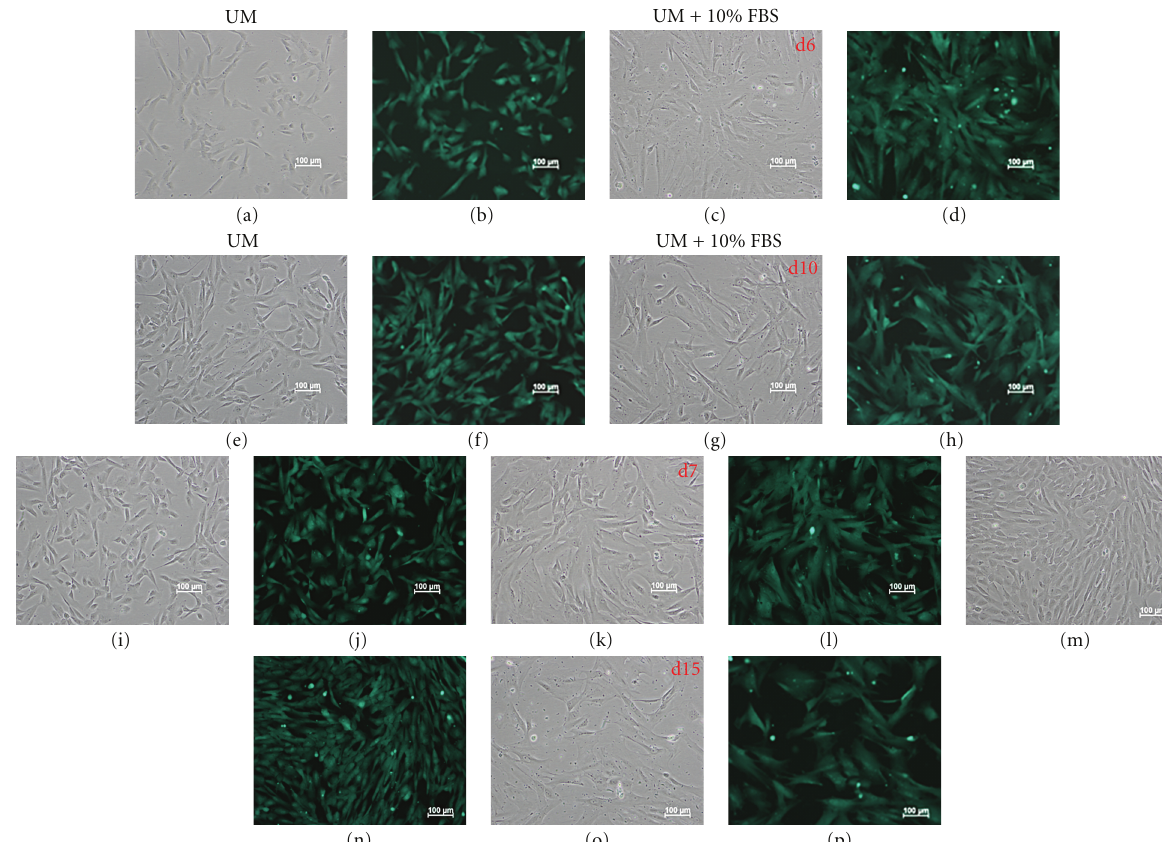
Figure 1: GFP expression in cNPCs transfected with pCAG-PyF101-eGFP plasmid. Transfected cNPC (passage 21) were maintained under proliferation conditions (UM) or switched to growth factor-free di ff erentiation conditions (UM + 10% FBS) to evaluate potential loss of transgene expression. Cultures were photographed at 6, 7, 10, and 15 days. Sustained expression of green fluorescence protein (GFP) was observed for both conditions at all time points. Paired images are shown for each time point and include phase contrast (a, c, e, g, i, k, m, o) and fluorescence (b, d, f, h, j, l, n, p) micrographs of the same areas in culture.